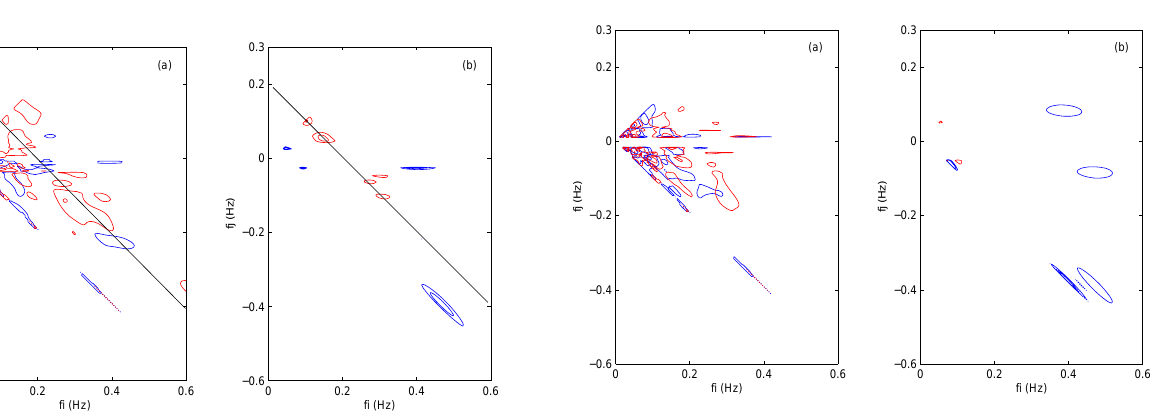
Fig. 6. Contours of (a) the wavelet bicoherence b 2 ηηu (contour lev- els: 0.45 and 0.8) and (b) the wavelet bispectrum B ηηu (contour lev- els: 0.7 and 0.9 times of the maximum value in stage I with extreme values at low frequencies eliminated) in stage I (blue contours) and stage II (red contours), respectively; all points on the black line in (a) have coordinates summed to be 0.1Hz.